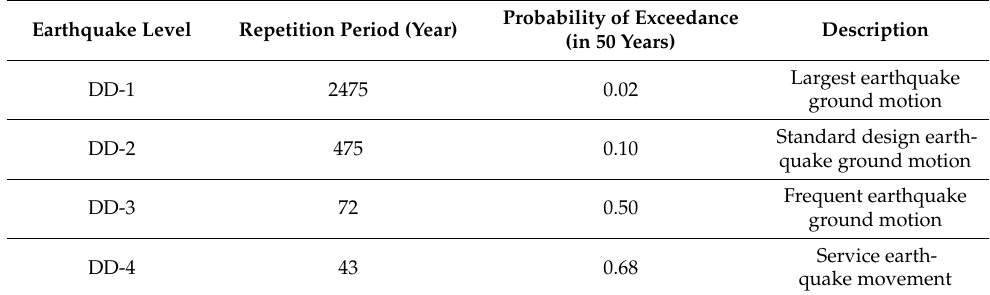
Table 3. Earthquake ground motion levels [27].